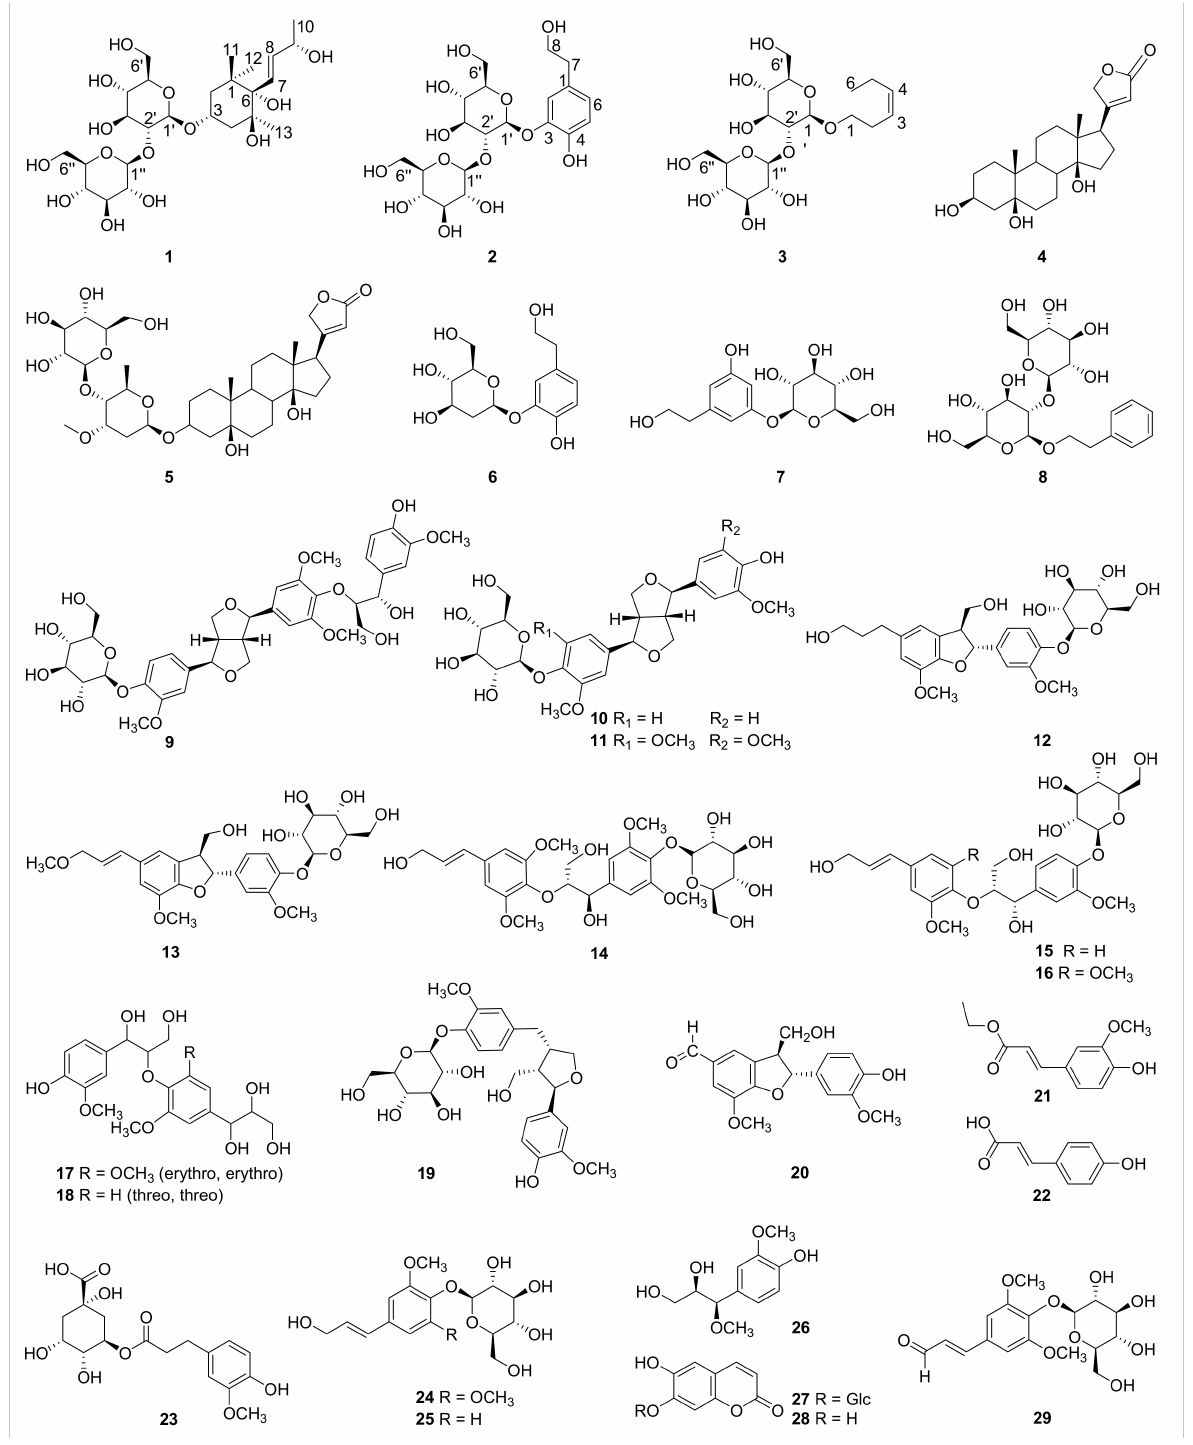
Figure 1. Chemical structures of compounds 1–29